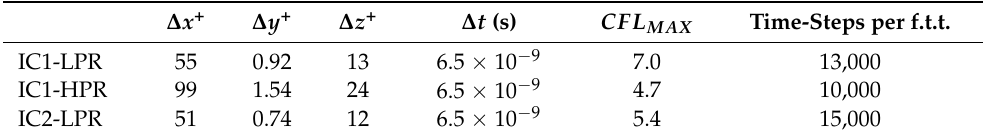
Table 3. Large eddy simulation (LES) parameters: ∆ x + , ∆ y + , and ∆ z + are the average sizes of the first cell close to the wall in wall units, ∆ t is the time step, CFL MAX is the maximum CFL number, and f.t.t. is the flow-through time. ∆ x + ∆ y + ∆ z + ∆ t (s) CFL MAX Time-Steps per